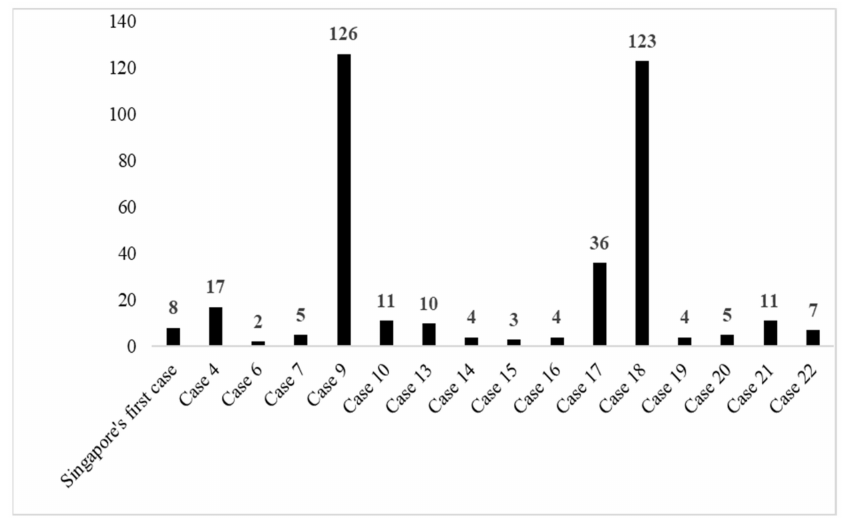
Figure 6. Number of close contacts traced by case in the first wave of COVID-19 in